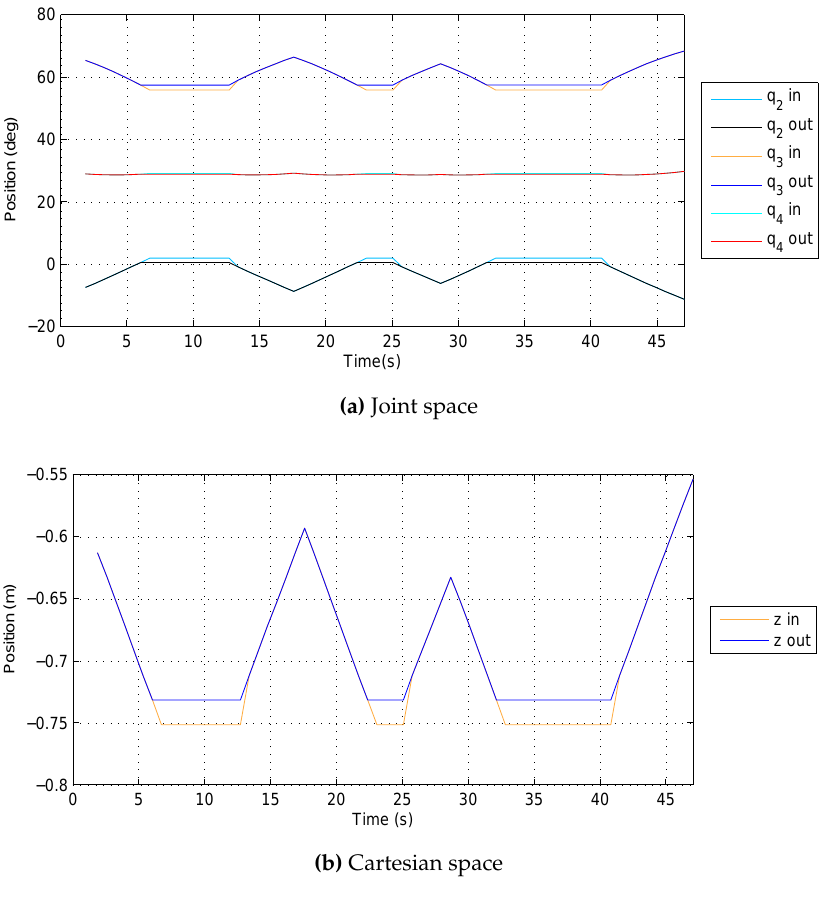
Figure 11. Reference input and collision-free output trajectories from the experiment.